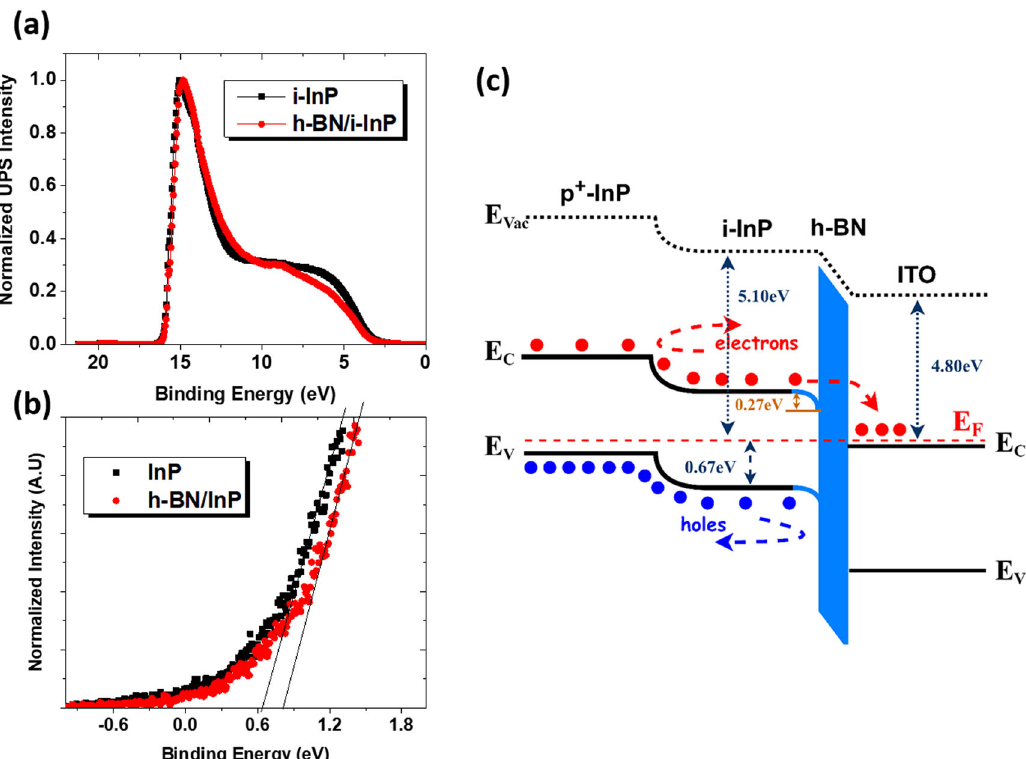
Fig. 4 UPS and band alignment of the solar cell. a Comparative UPS spectra of i-InP with and without hBN monolayer. b Magni fi ed valence band contribution of the UPS spectra of i-InP with and without hBN layer. c Band diagram drawn using UPS data to show the band bending at the interface of hBN/i-InP.